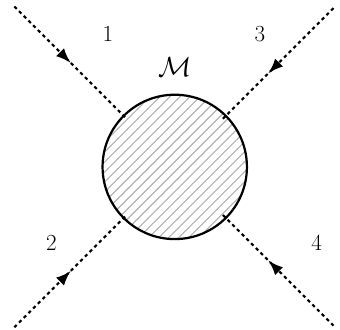
Figure 1. The 2 → 2 scattering process studied in this paper. For different choices of four- momenta, time can flow either horizontally or vertically (or